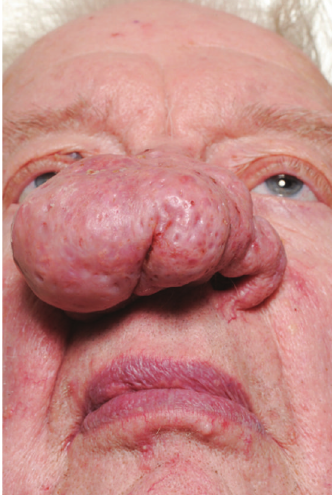
Figure 4: Case 3, preoperative basal photos.